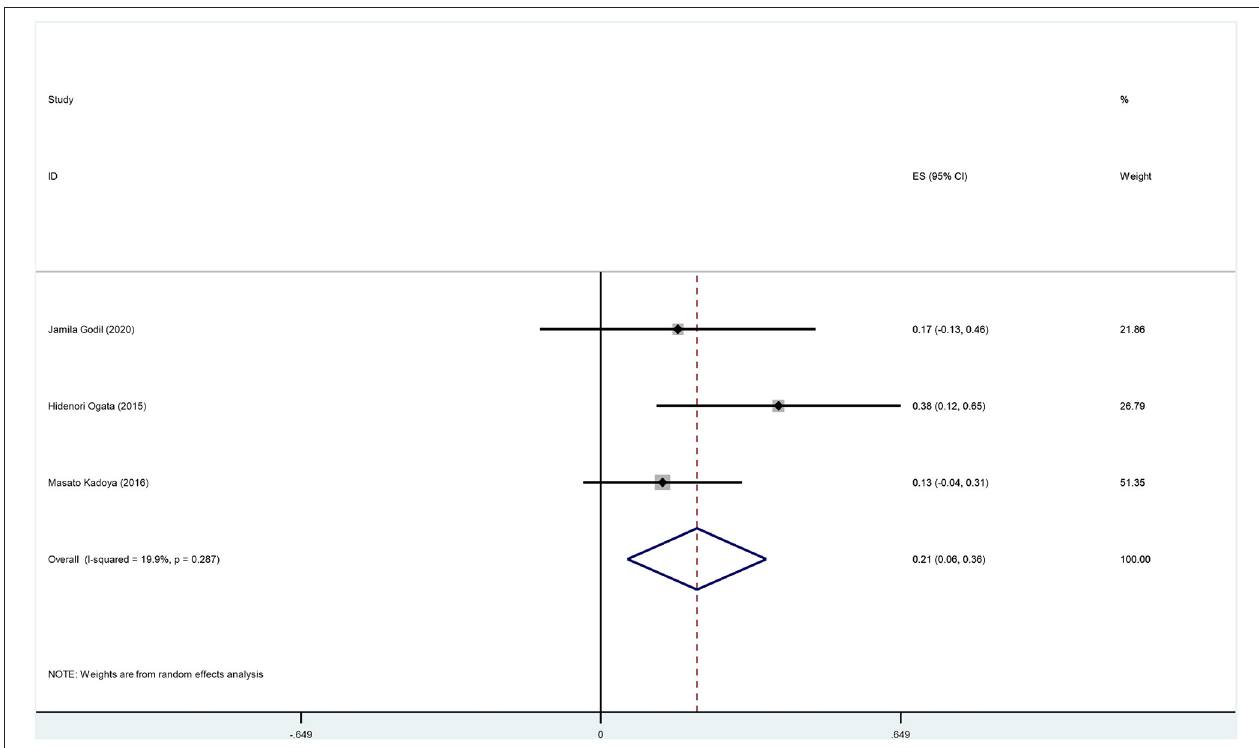
FIGURE 8 | The forest plot of incidence of